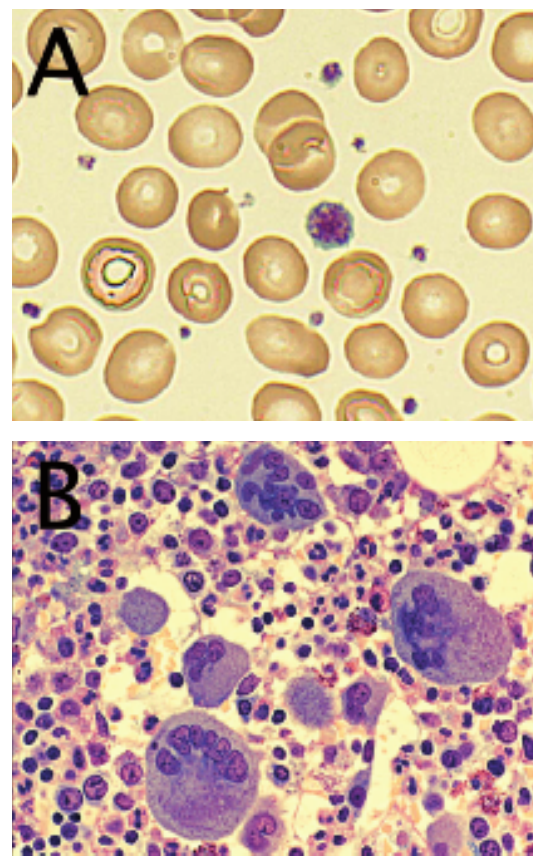
Hemoglobin and anemia. Hemoglobin values were normally distributed (A). While only a few results lied above the upper reference value, a substantial number of cases ranged below the lower limit of normal (140 g/L) and 9 cases showed a significant degree of anemia (<120 g/L, B). The area shaded in green indicates the normal